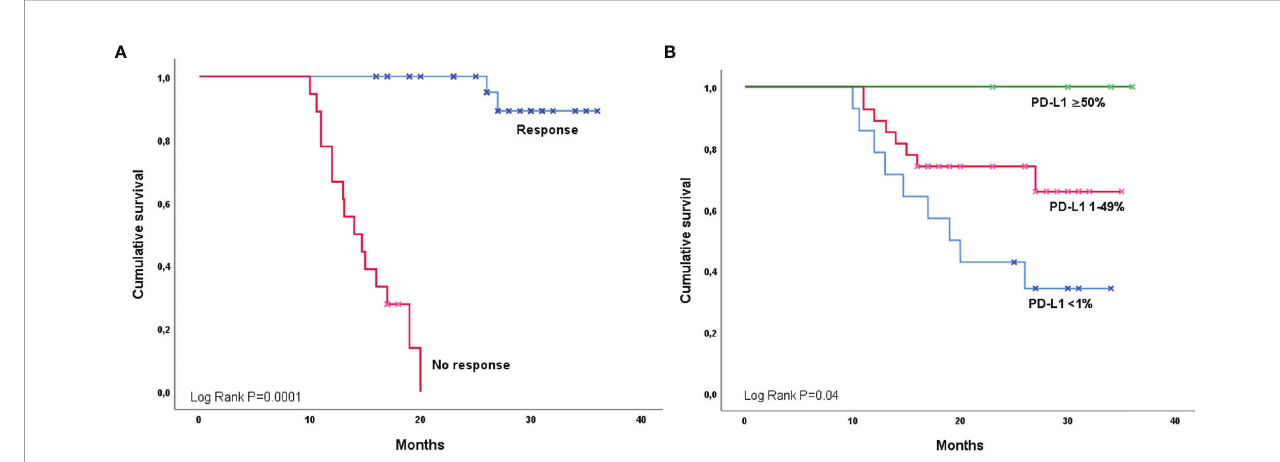
FIGURE 3 | Overall survival among NHWs according to response (A) and PD-L1 expression (B) .